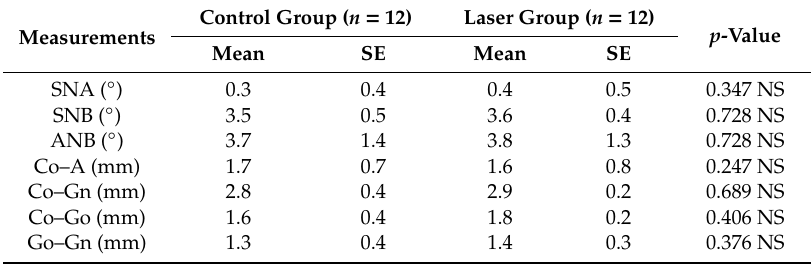
Table 9. Comparison of changes (T1-T2) in skeletal measurements between laser and control groups using independent sample t